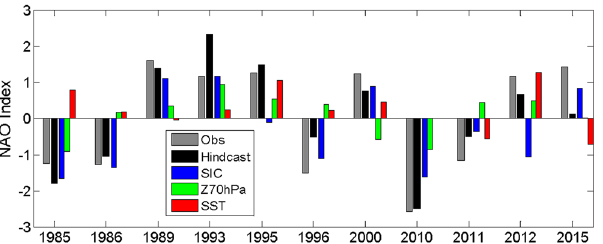
Figure 3. Contribution of NAO hindcast (grey) from October SIC PC1 (blue), October Z70 hPa PC2 (green), and September SST PC3 (red), for strong NAO winters (amplitude > 1.1).